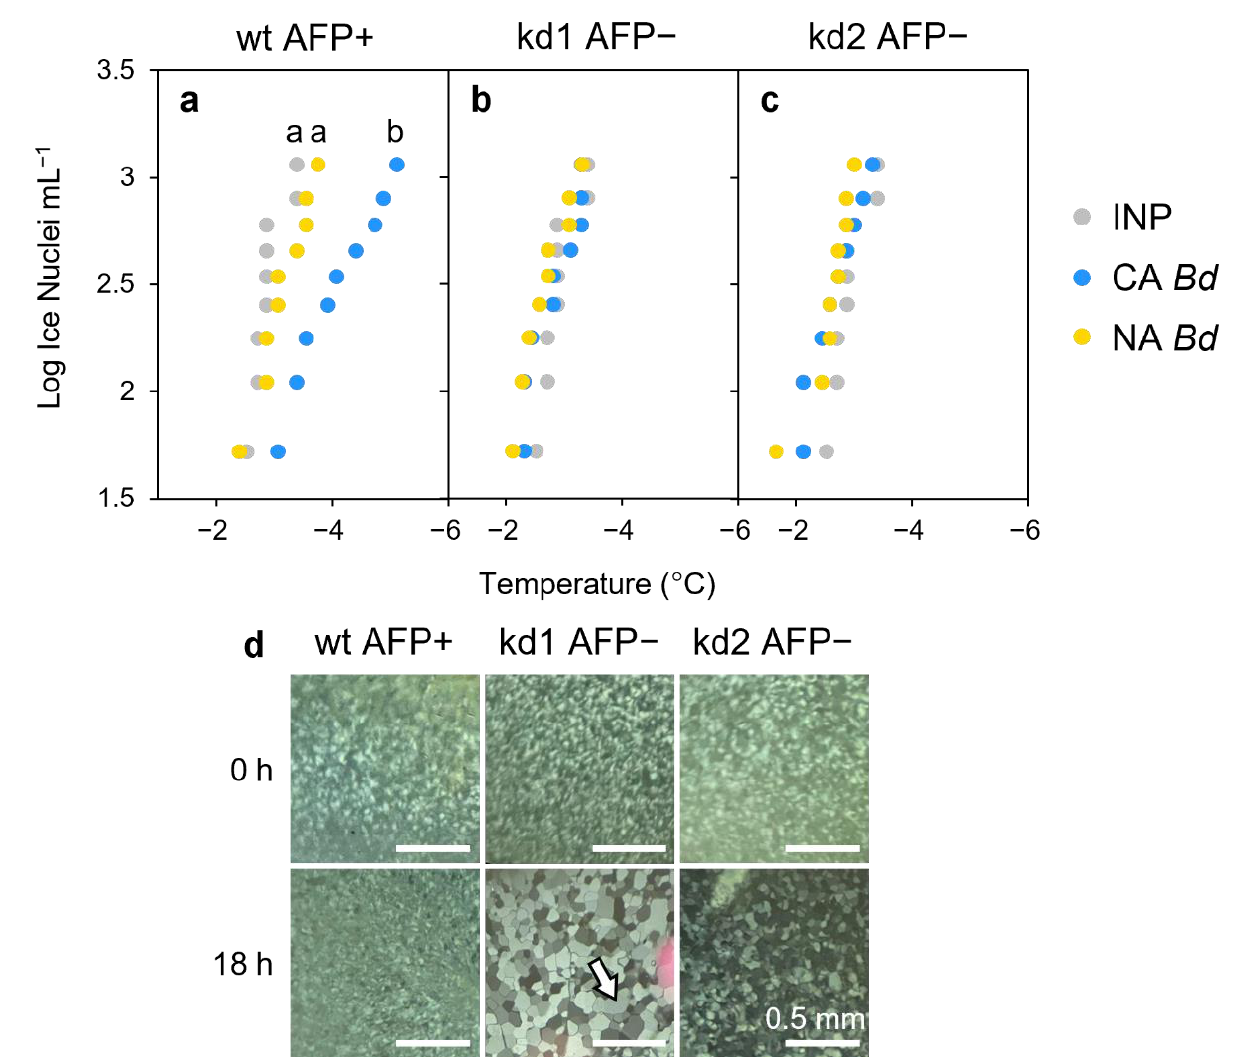
Figure 1. Impact of Brachypodium leaf tissue lysates or apoplast extracts on ice nucleation or ice crystal size. ( a ) Representative ice nucleation assays conducted using ice nucleating protein (INP) preparations (50 µg mL − 1 ) and concentrated leaf lysates of Brachypodium leaf tissue (final concentration of 20 mg mL − 1 ). Lowercase letter groupings indicating significance ( p < 0.005, one way ANOVA) are shown as applicable. Samples (10 per plate) were repeated in triplicate with similar results. Comparison between INPs alone (grey dots) and INPs combined with lysates from cold-acclimated (CA; blue) or non-acclimated (NA; yellow) wildtype Brachypodium (Bd21). Notably, the CA leaf lysates were comparably effective as the − 1.26 °C depression of INP activity by purified recombinant Bd AFPs at equal concentration [9]. ( b ) Comparison between INPs alone (grey dots) and INPs combined with lysates from the low temperature-induced transgenic Bd AFP knockdown line (prOmiRBdIRI-1e) that was either CA (blue) or NA (yellow). ( c ) Comparison between INPs alone (grey dots) and INPs combined with lysates from the low temperature-induced transgenic Bd AFP knockdown line (prOmiRBdIRI-3c) that was either CA (blue) or NA (yellow). ( d ) Ice-recrystallisation inhibition activity in diluted (0.01 mg mL − 1 ) apoplast extracts from leaves of cold-acclimated wildtype plants (left) and reduced activity in two CA knockdown lines (prOmiRBdIRI-1e, middle, and prOmiRBdIRI-3c, right). Ice crystal sizes following an 18 h annealing period at − 8 °C (lower images) are compared to those seen immediately after flash freezing (upper images). Scale bars represent 0.5 mm. The white arrow in the kd1 AFP − sample after annealing for 18 h indicates a single grown ice crystal for reference.